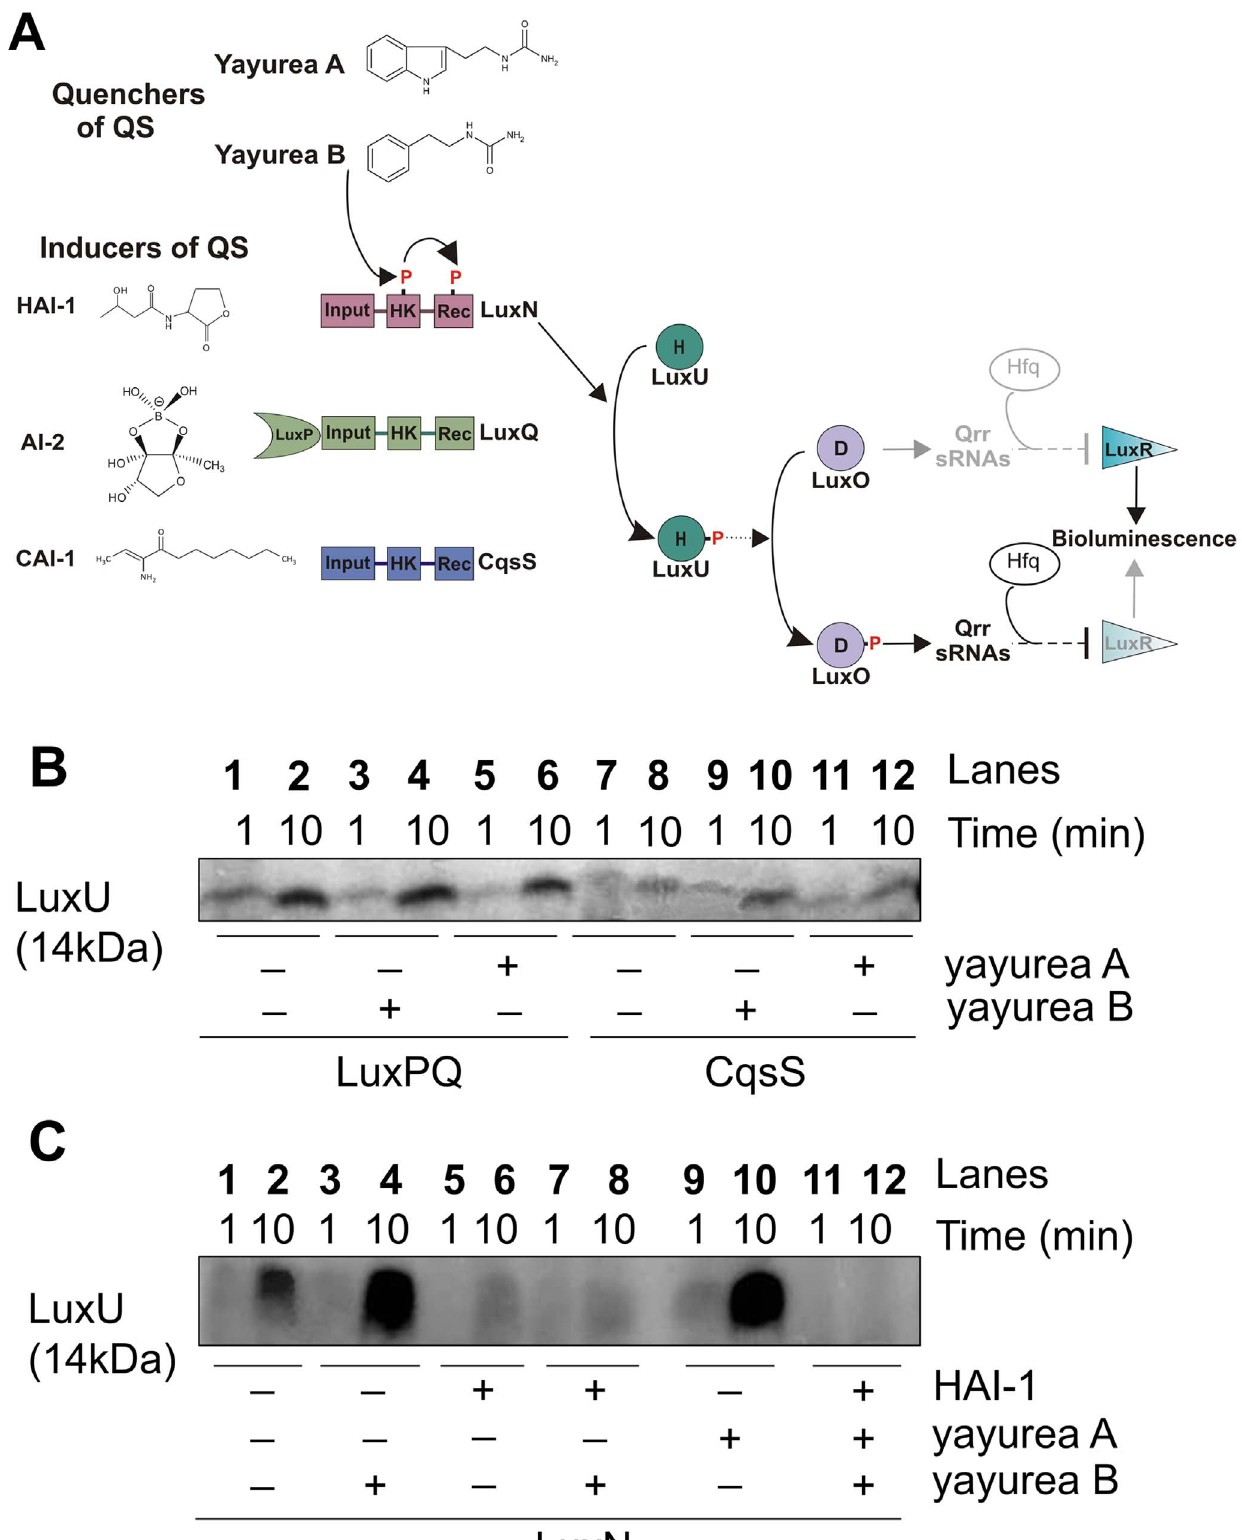
Figure 7. Yayurea A and B are perceived by V.harveyi LuxN receptor. ( A ) Schematic representation of the QS phosphorelay in V. harveyi . In the absence of autoinducers (HAI-1, AI-2 and CAI-1) at low cell density, each of the three receptors, LuxN, LuxQ and CqsS, respectively, autophosphorylates at a conserved histidine of their histidine kinase domain (HK). The phosphoryl group is first transferred to the receiver domain (Rec) of the receptor kinase and then to the HPt protein LuxU. LuxP is a periplasmic binding protein. P denotes phosphorylation sites. Upon